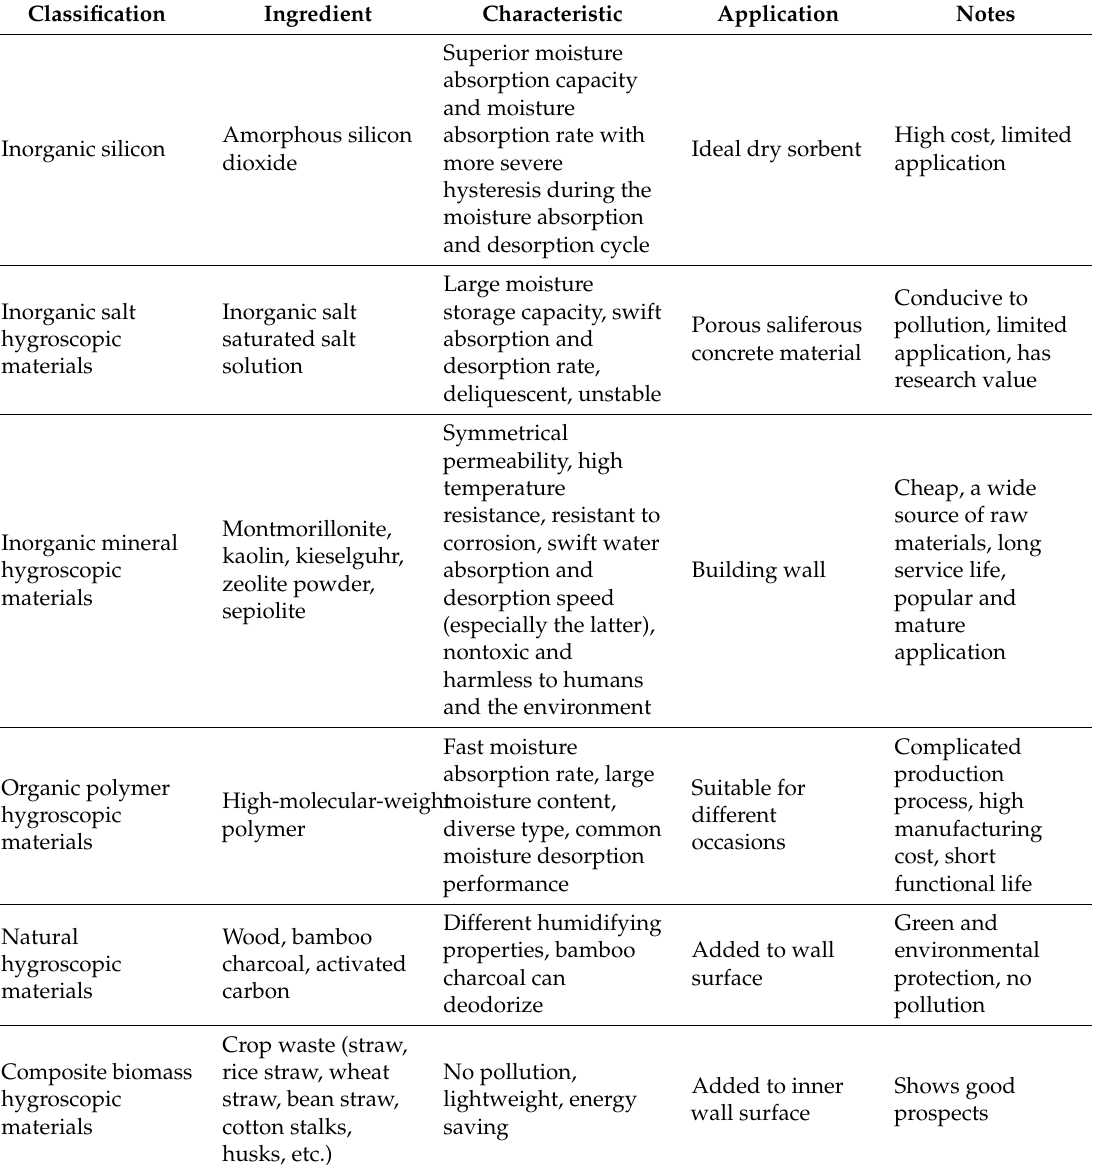
Table 1. Hygroscopic material